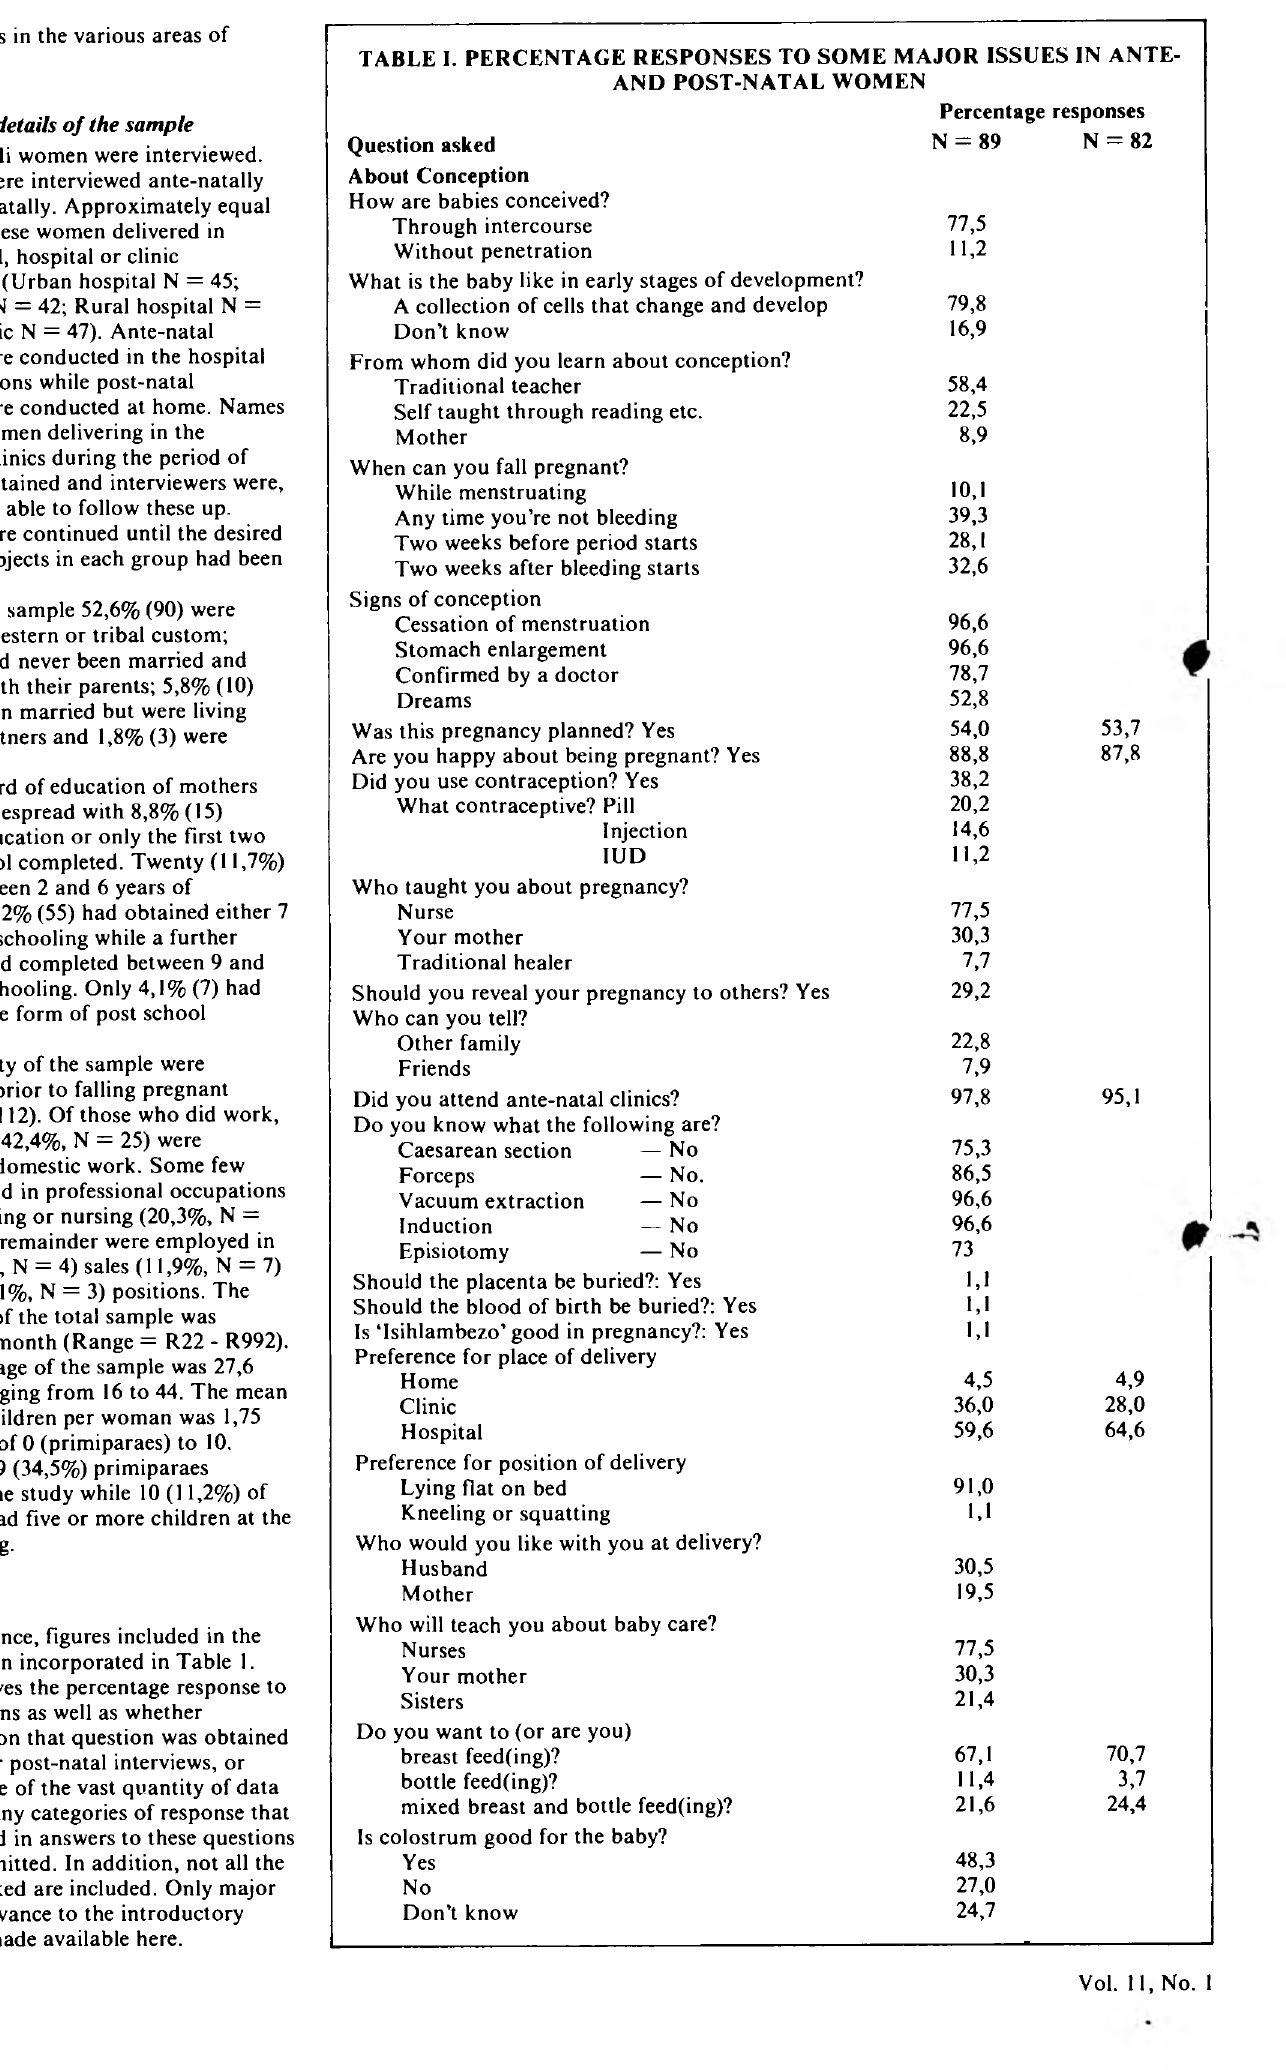
TABLE I. PER C EN TA G E R E SPO N SES TO SO M E M A JO R ISSU ES IN ANTE- AN D PO ST-N A TA L W OM EN Percentage